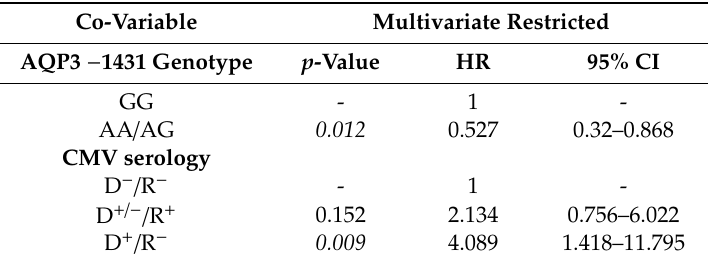
Table 6. Restricted multivariable Cox regression analysis of kidney transplantation recipients with respect to the e ff ect on CMV